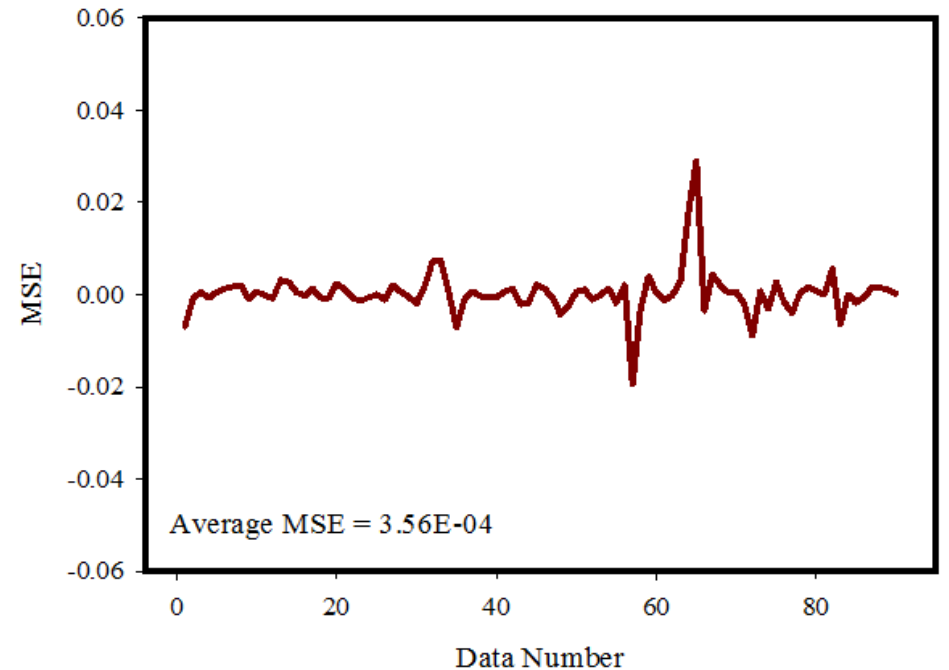
Figure 7. The MSE values calculated for each datapoint of the MLP neural network model.